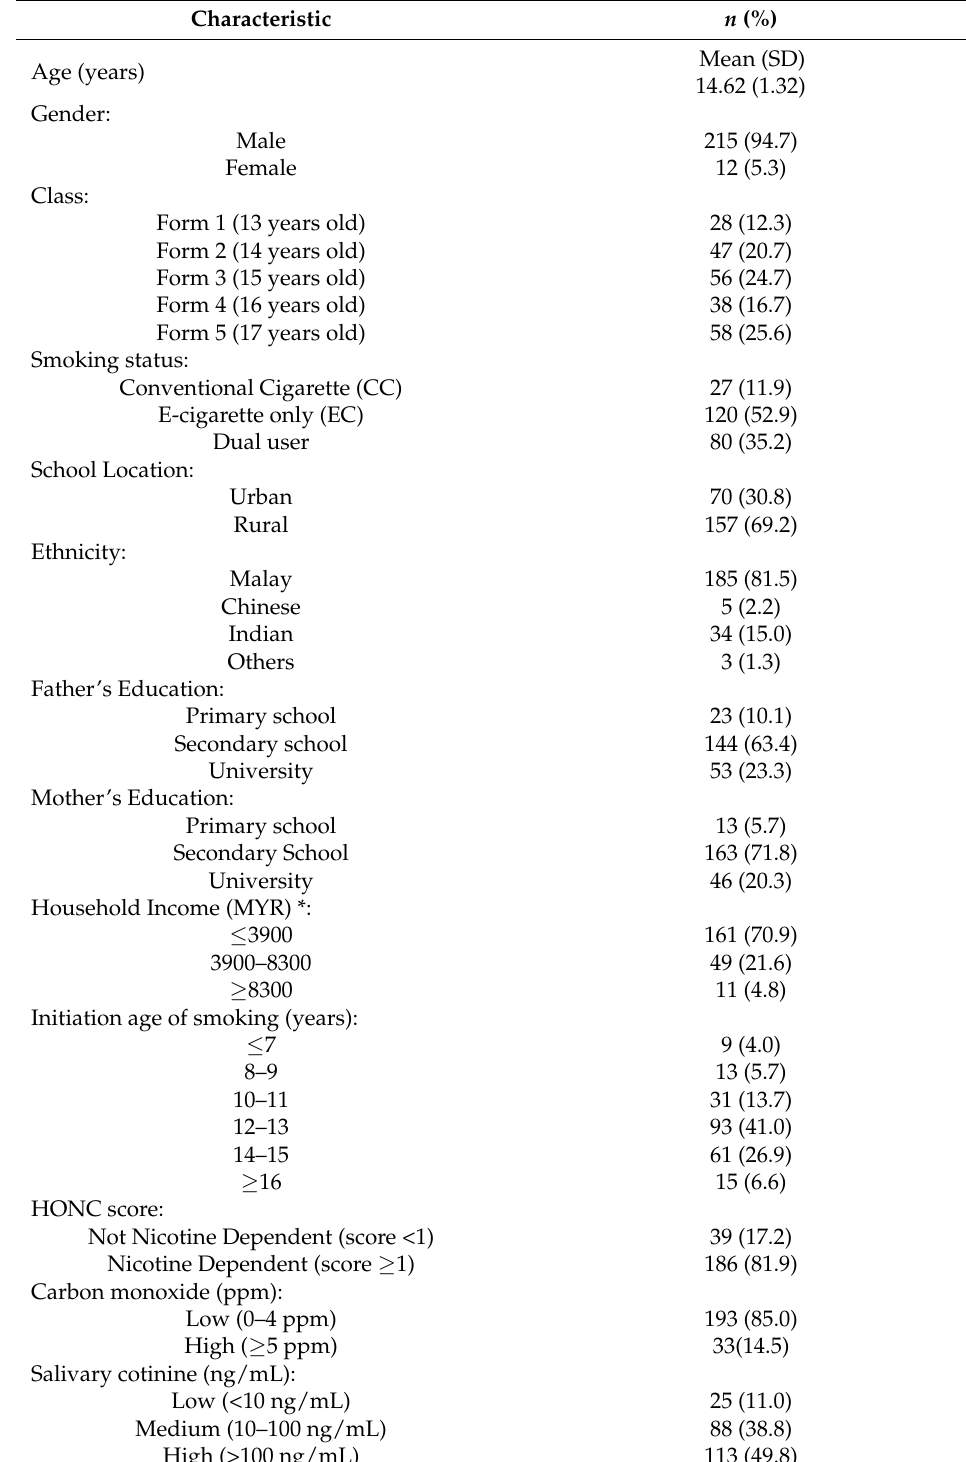
Table 1. Sociodemographic characteristics of the study